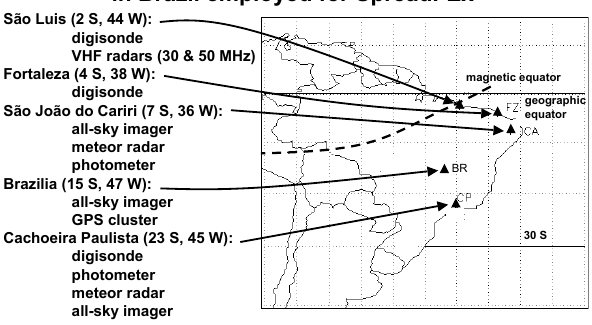
Fig. 2. Measurement sites in Brazil employed for the SpreadFEx measurement campaigns. GPS receivers were much more widely distributed, with ∼ 25 sites available for